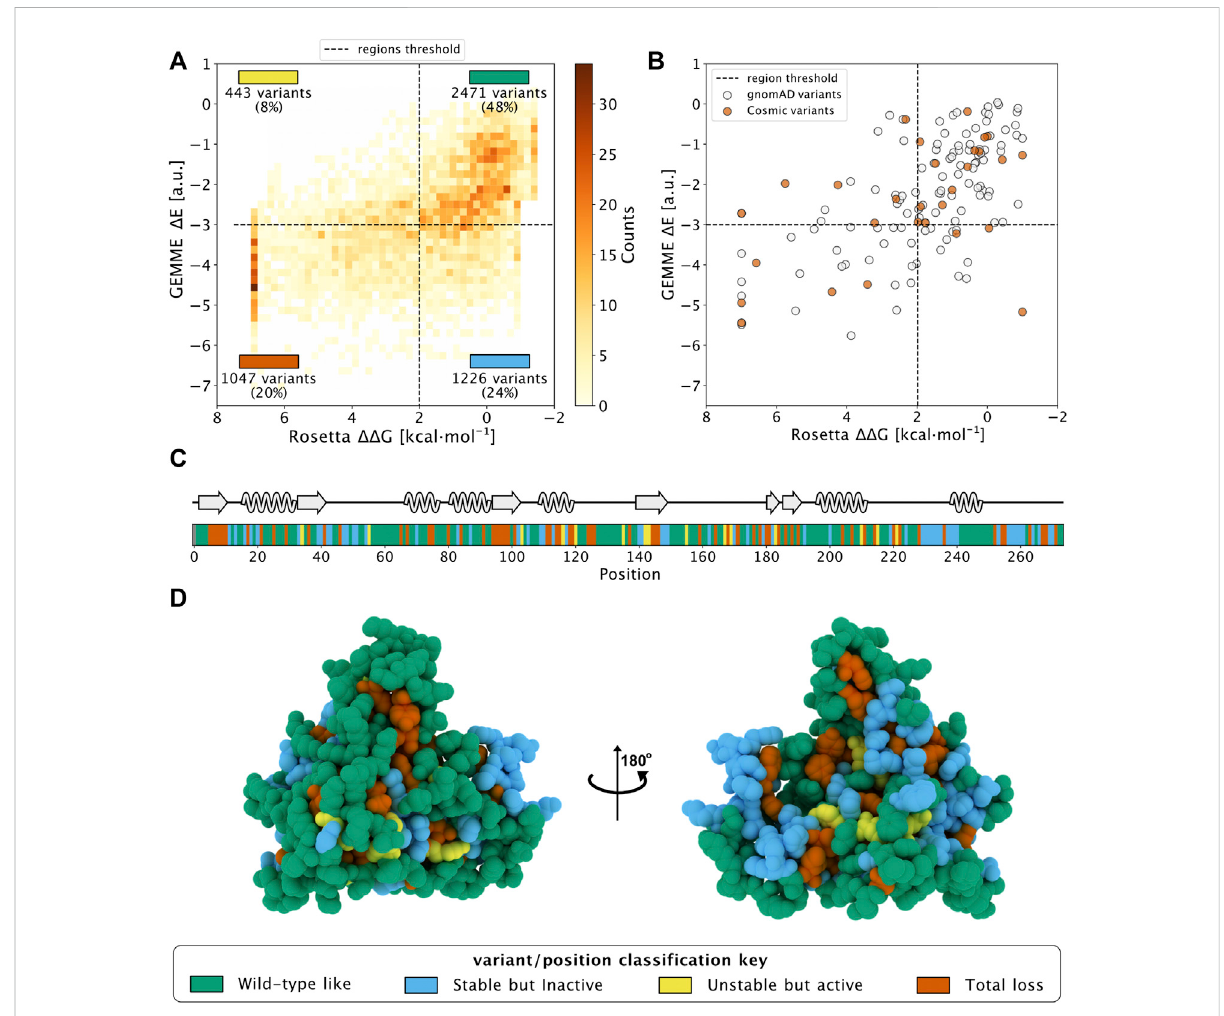
FIGURE 1 Saturation mutagenesis of NQO1 based on computational methods. (A) Two-dimensional histogram which combines the data from the evolutionaryconservationanalysis( Δ E, y -axis)withthethermodynamicstability( ΔΔ G, x -axis)datafromRosettaontheNQQ1monomer.Thevariants are categorized in one of the four regions, whichare delimited by dashed lines. The fraction of variants, class and colour assigned to each region are indicated. The four classes of variants/positions are reported at the bottom of the fi gure: “ WT-like ” (Green), “ Low stability, active ” (yellow), “ Stable but inactive ” (blue) and “ Total-loss ” (red). (B) The scores of gnomAD (grey) and COSMIC (orange) variants in the 2D histogram. (C) The positionalcolour categoriesassignedusingthemostcommoncolour ofthepositioninthesequence togetherwiththesecondarystructure. (D) The positional classi fi cation mapped to the protein crystal structure (PDB: 1D4A) (Faig et al.,